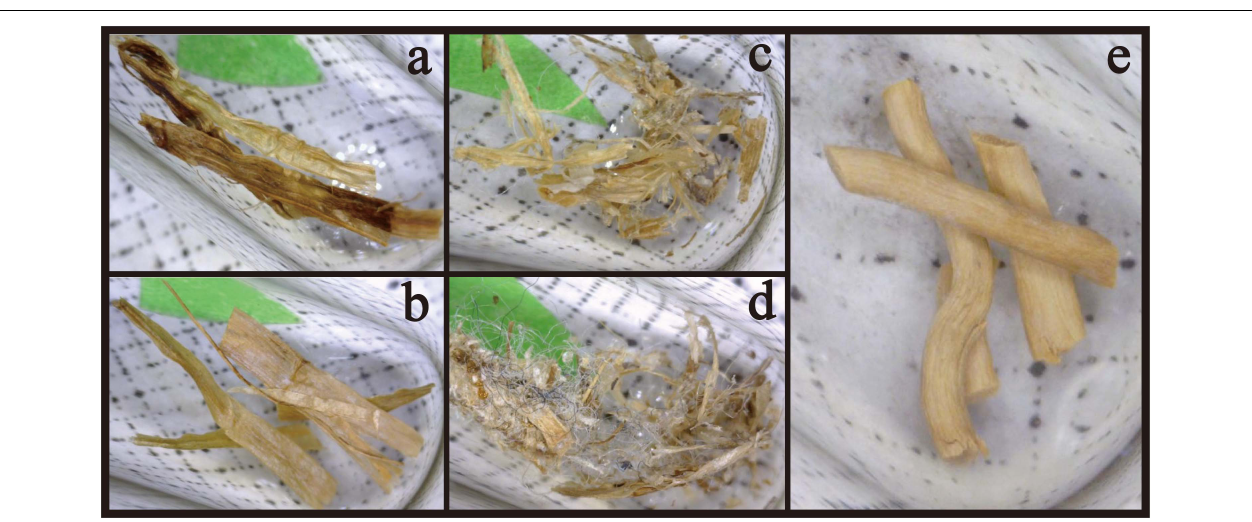
FIGURE 3 | Photos of radiocarbon dating samples. (a–d) Are aquatic plant remnants, (e) is terrestrial plant